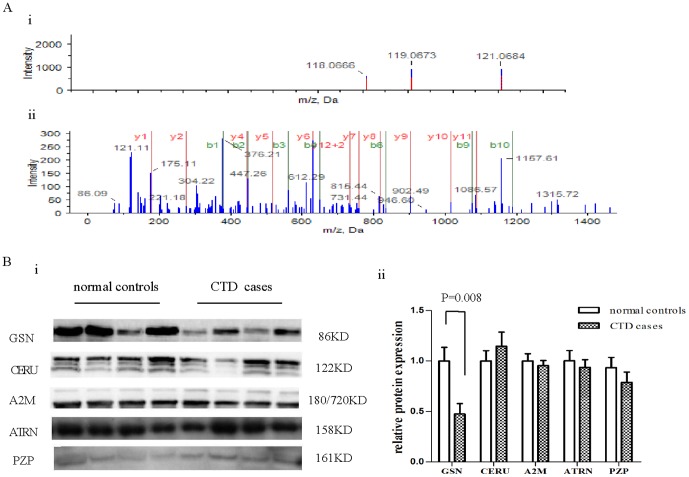
Identification of the protein gelsolin as being differentially expressed in maternal sera of pregnant women carrying a CTD fetus.(A) Identification of the protein gelsolin in maternal serum by iTRAQ and 2D LC-MS/MS. (i) The peptide quantitation information of gelsolin was derived from the intensities of three iTRAQ reporter ions. Reporter ions 118,119 were used to label sera from pregnant women carrying CTD and ACHD fetuses, respectively. Reporter ion 121 was used to label normal controls. (ii)The representative MS/MS spectrum of a peptide from gelsolin. (B). The Western blot validated the relative expression of GSN, A2M, CERU, ATRN, PZP in maternal serum samples(i), and confirmed relative decreased level of maternal serum gelsolin in CTD group compared with normal controls (ii). n = 9 in CTD group, n = 11 in normal control.*p = 0.008.